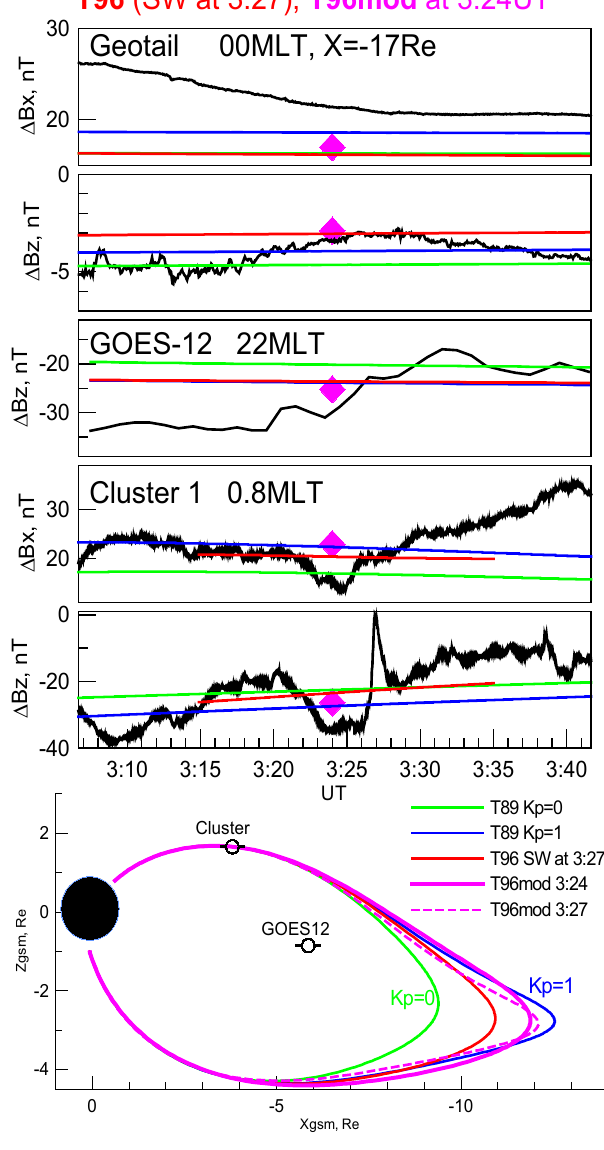
Fig. 10. Magnetic field observations at Geotail, G12, Cluster with dipole field subtracted (a–c) compared with predictions of different models T89, T96, T96mod. Magnetic field lines traced through the Cluster location using different